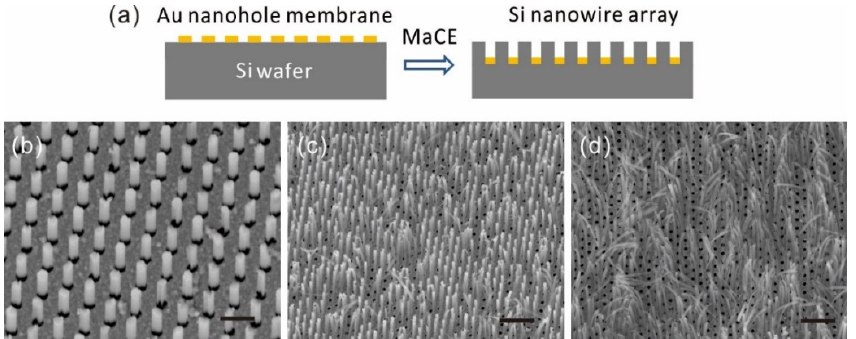
Figure 4. ( a ) Schematic of metal-assisted chemical etching with freestanding nanohole membrane for fabrication of nanowire array. ( b – d ) Nanowire arrays etched by using the same nanomembrane with different etching time of 1 min, 3 min, and 5 min, respectively. Scale bars: 1 μ m in ( b ); 2 μ m in ( c , d ).